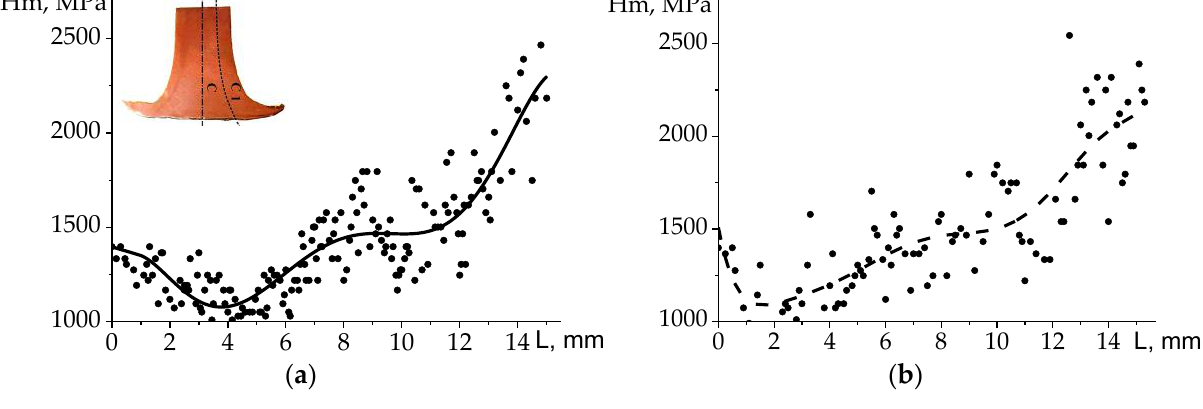
Figure 4. Averaged microhardness distribution of the copper specimen along line C ( a ) and C1 ( b ) at the impact velocity of 316 m/s.